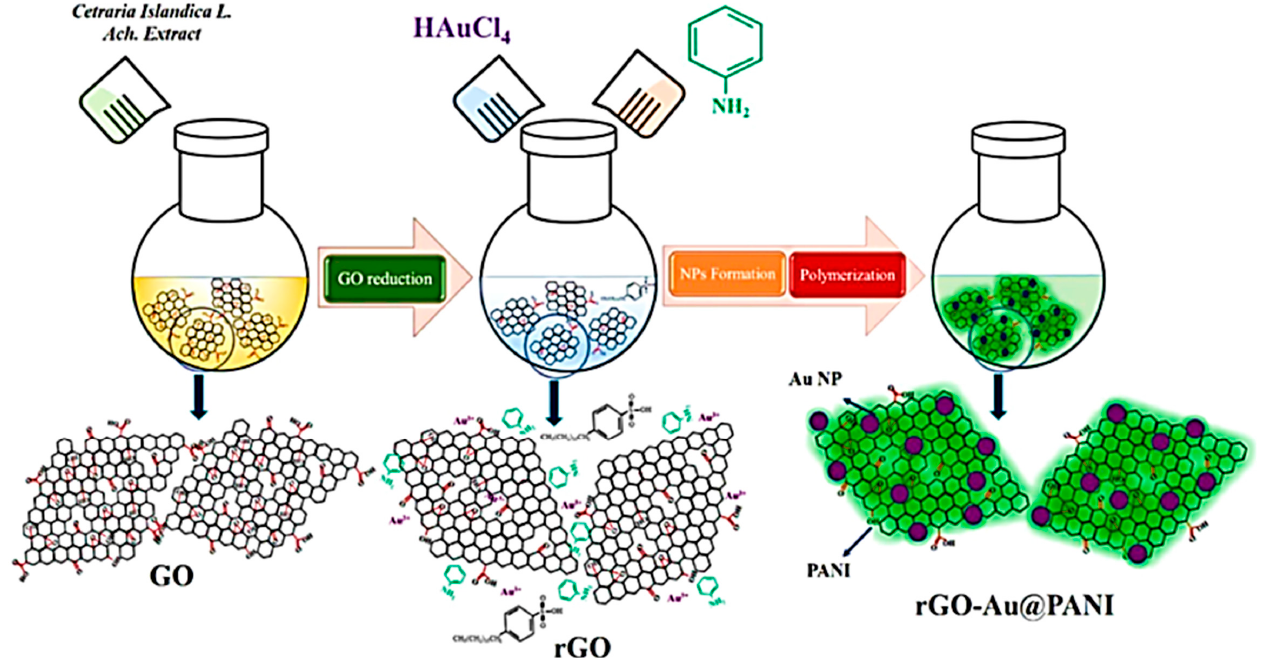
Figure 8. Schematic representation of preparation of rGO-Au@PANI nanocomposite [122]. PANI = polyaniline; GO = graphene oxide; rGO = reduced graphene oxide; rGO-Au@PANI = reduced graphene oxide-gold@polyaniline. Reproduced with permission from Elsevier.